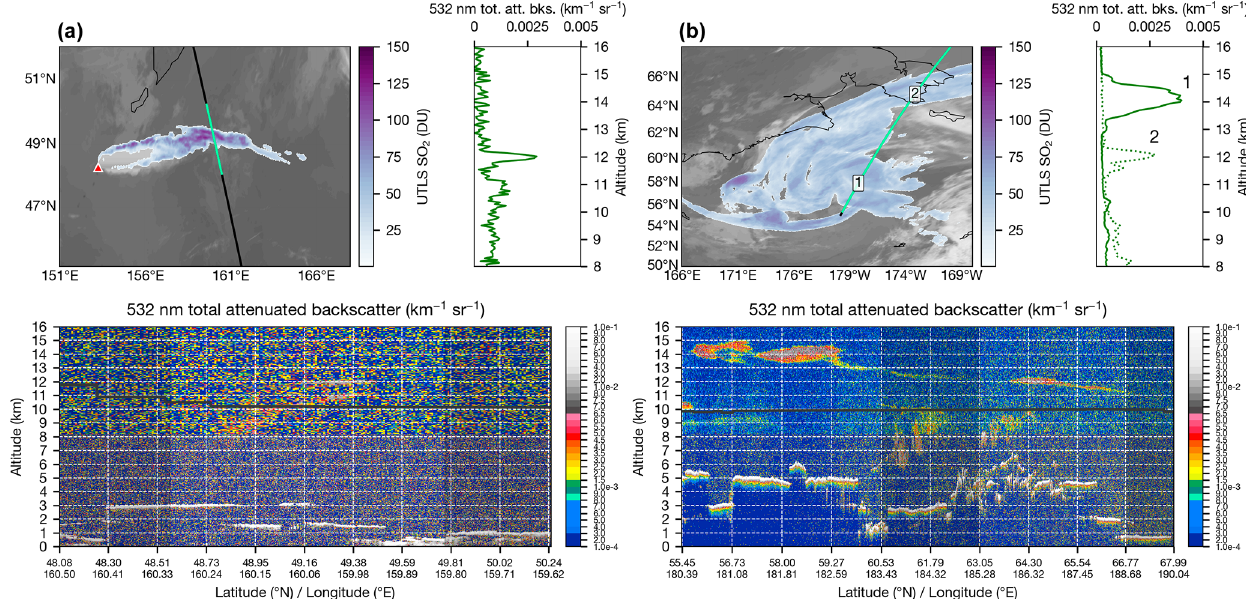
Figure B3. (a) AHI SO 2 UTLS total column burdens (DU) and CALIOP vertical profile of the Raikoke SO 2 plume on 22 June 2019 at 02:00UTC. Top left panel: 7.3µm SO 2 total column retrievals (white–purple–green–red colour scale) with 11µm brightness temperatures plotted underneath (the red triangle indicates the location of Raikoke). The black line indicates CALIOP track and green highlight indicates full latitude–longitude range displayed in the bottom panel. Top right panel: 532nm total attenuated backscatter profile averaged over the latitude–longitude range highlighted in the bottom panel. Bottom panel: 532nm total attenuated backscatter curtain (the black line indicates the tropopause). Panel (b) is the same as (a) but for 25 June 2019 at 14:00UTC.